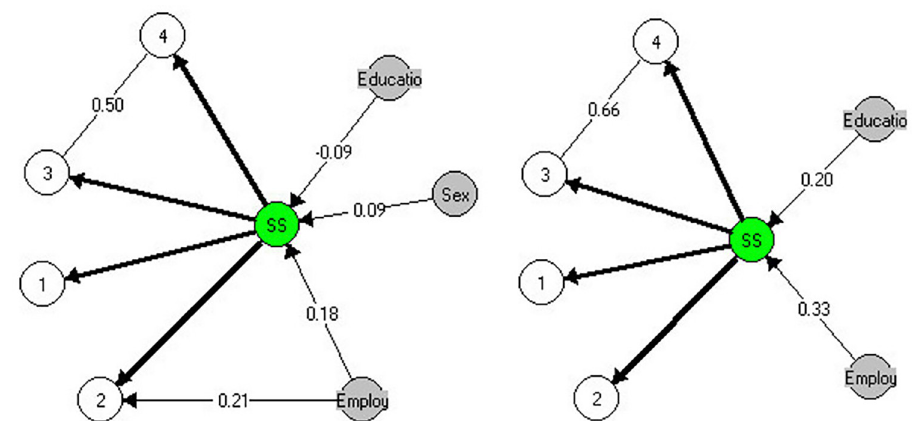
Fig 1. GLLRMs of the SSS for sample 1 (left) and sample 2 (right). Note. The Markov graph nodes represent the item numbers, the exogenous variables, and the latent trait. Disconnected nodes indicate that variables are conditionally independent and partial γ inform the magnitude of the LD and DIF. When LD/DIF was unsubstantial ( γ < 0.1), the edges were omitted (see S1 Fig). https://doi.org/10.1371/journal.pone.0279954.g001 misfit (S2 Table) and LD or DIF (S4 Table), the measurement model for the SSS in Sample 2 was established.